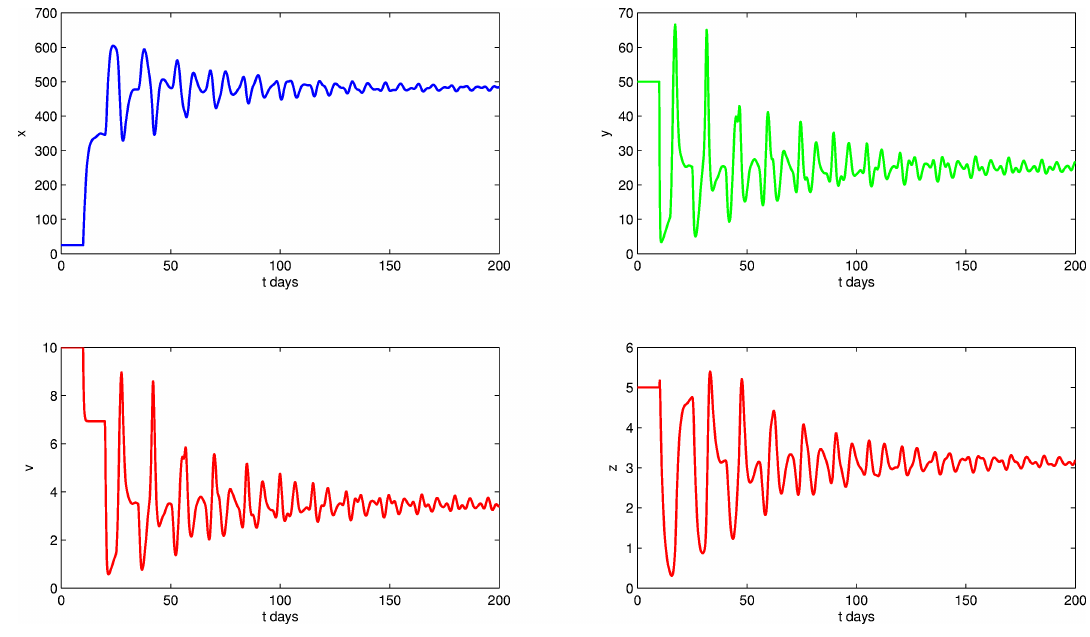
Fig. 4. Global stability of CTL-AE E 2 for f ( x , y , v )